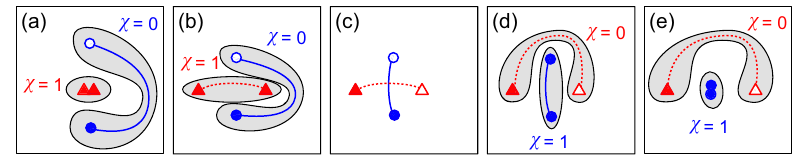
Fig. 8 Schematic braiding process in the vicinity of Γ with broken C 6 symmetry. The braiding processes lead to the transfer of charge (frame charge − 1, equivalently Euler class 1) from gap Δ 11 (red triangles) to gap Δ 10 (blue circles). The successive panels a – e correspond to the braiding of Fig. 7b with ε < t < 1 − ε . The panels b – d have the same positions of nodes, while the Dirac strings are moved around and the charges are fl ipped